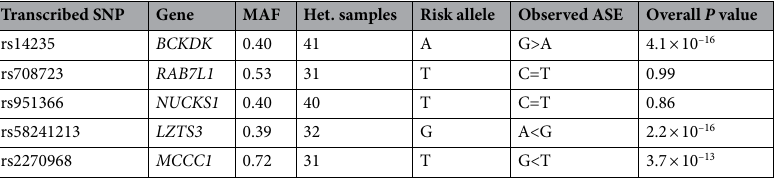
Table 3. Allelic expression analysis results for five Parkinson’s disease-associated genes in blood samples. The overall P value was calculated using a non-parametric Mann–Whitney U test comparing the allelic expression of all genomic DNA samples with all cDNA samples. SNP single nucleotide polymorphism, MAF minor allele frequency, Het heterozygous, ASE allele-specific expression.